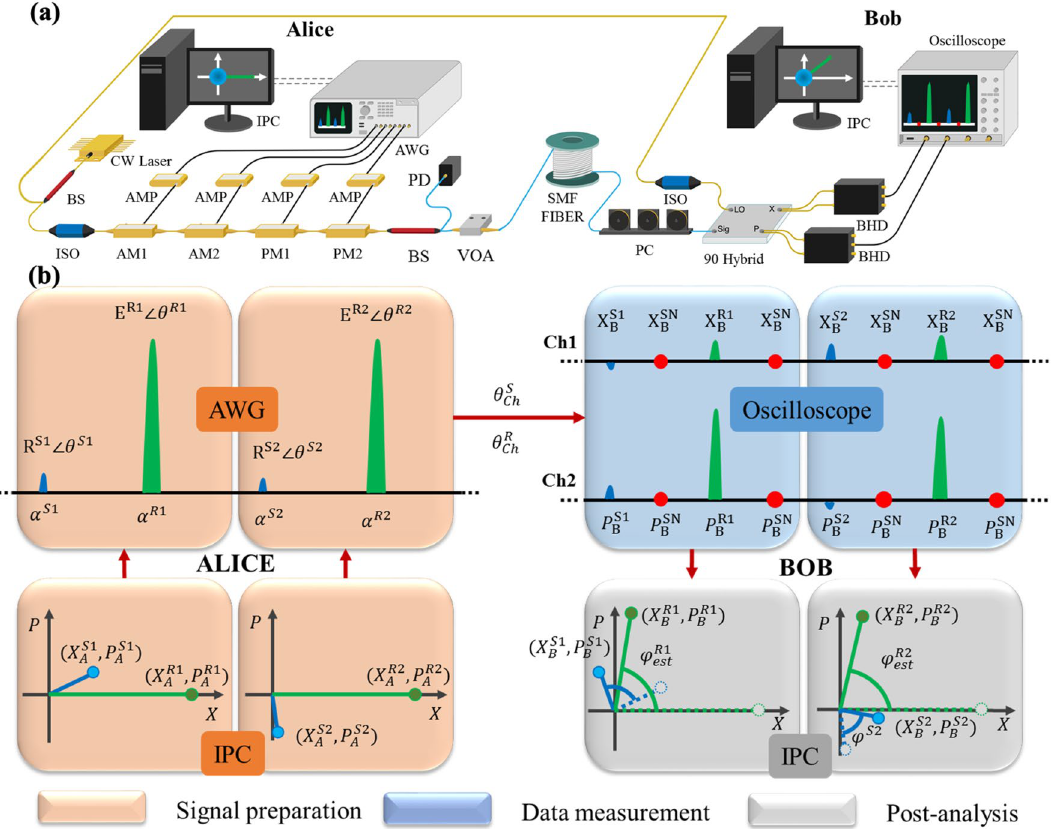
Figure 1. Experiment setup and data processing unit of our LLO CVQKD system. ( a ). Overall system configuration. The system has been tested with a second laser at Bob and the experimental results are equivalent to those presented here. The SMF length (15 km) is significantly longer than the coherence length of the laser (954 m). CW: continuous wave, AWG: arbitrary wave generator, BS: beam splitter, ISO: isolator, AMP: AC coupled wideband amplifier, AM: amplitude modulator, PM: phase modulator, VOA: variable optical attenuator, PD: photodiode; SMF: single mode fibre, PC: polarization controller, 90 Hybrid: 90 degree optical hybrid, BHD: balanced homodyne detector. ( b ). Schematic representation of the data processing unit along with the phase recovery scheme. In Alice’s signal preparation stage (orange region), quadratures of quantum signal pulses (blue) and reference pulses (green) are generated in an industrial PC (IPC) and converted into phase- space representation for signal modulation in the AWG. At Bob, the data measurement process (blue region) collects the X and P of signal pulses, reference pulses and real-time shot noise (red) from Ch1 and Ch2 of the oscilloscope. Then, the post-analysis (grey region) is implemented to recover the phase rotation ϕ S (blue angle) by estimating the rotation in the reference phase ϕ R est (green